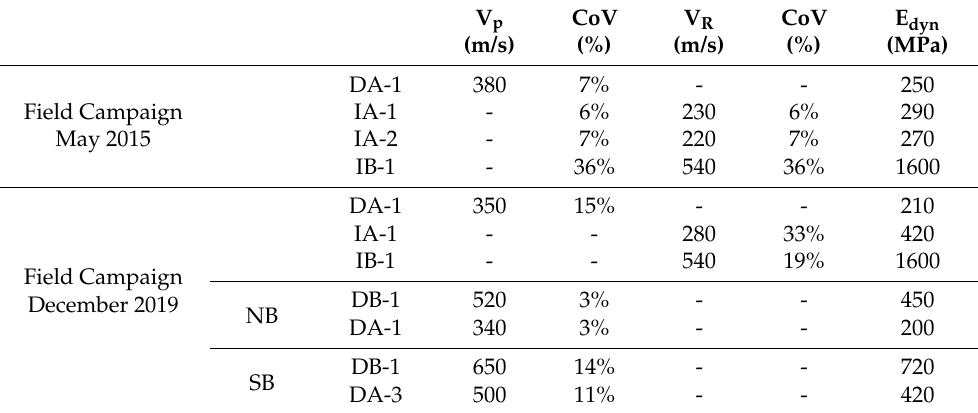
Table 1. Results for the sonic tests in the Church of Kuñotambo during the un-retrofitted (field campaign in May 2015 [4]) and retrofitted (field campaign in December 2019)